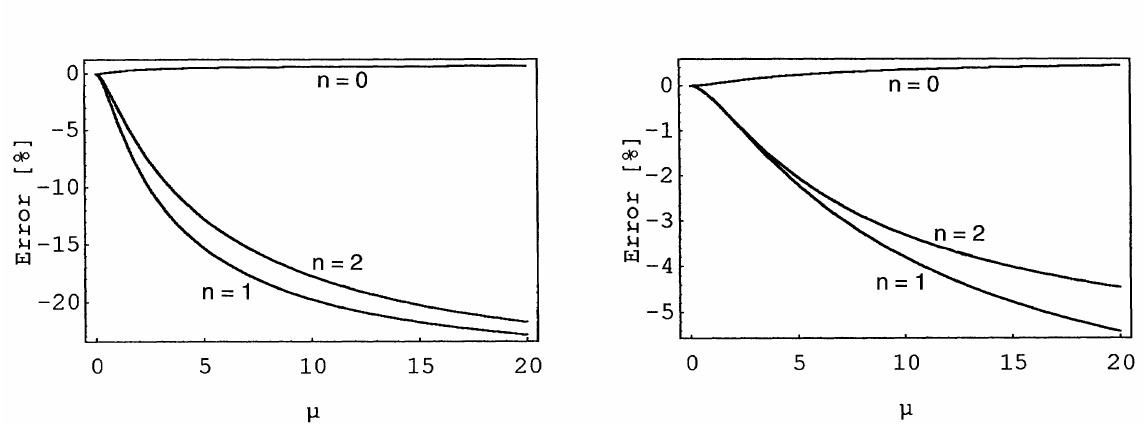
FIGURE 8 The percentage errors of the N A VMI fac tor solution in respect to the Rayleigh-Ritz results as a function of /L for clamped plates. Modes with a nodal diameter (m = 1) and H/a =